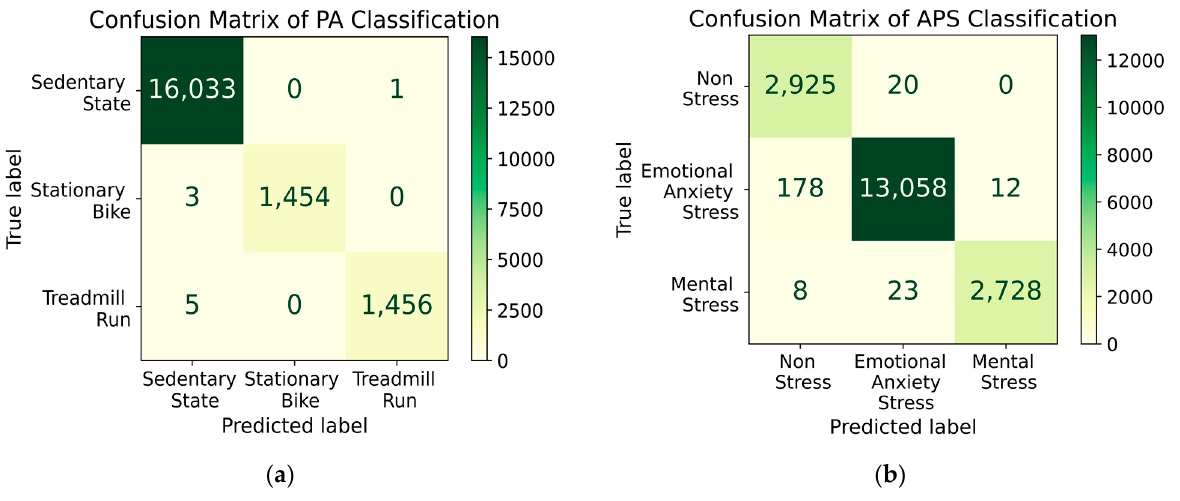
Figure 11. ( a ) Confusion matrix of PA types classification using the multi-task XGBoost classifica- tion of APS types and PA types (class imbalance mitigated by ADYSN); ( b ) Confusion matrix